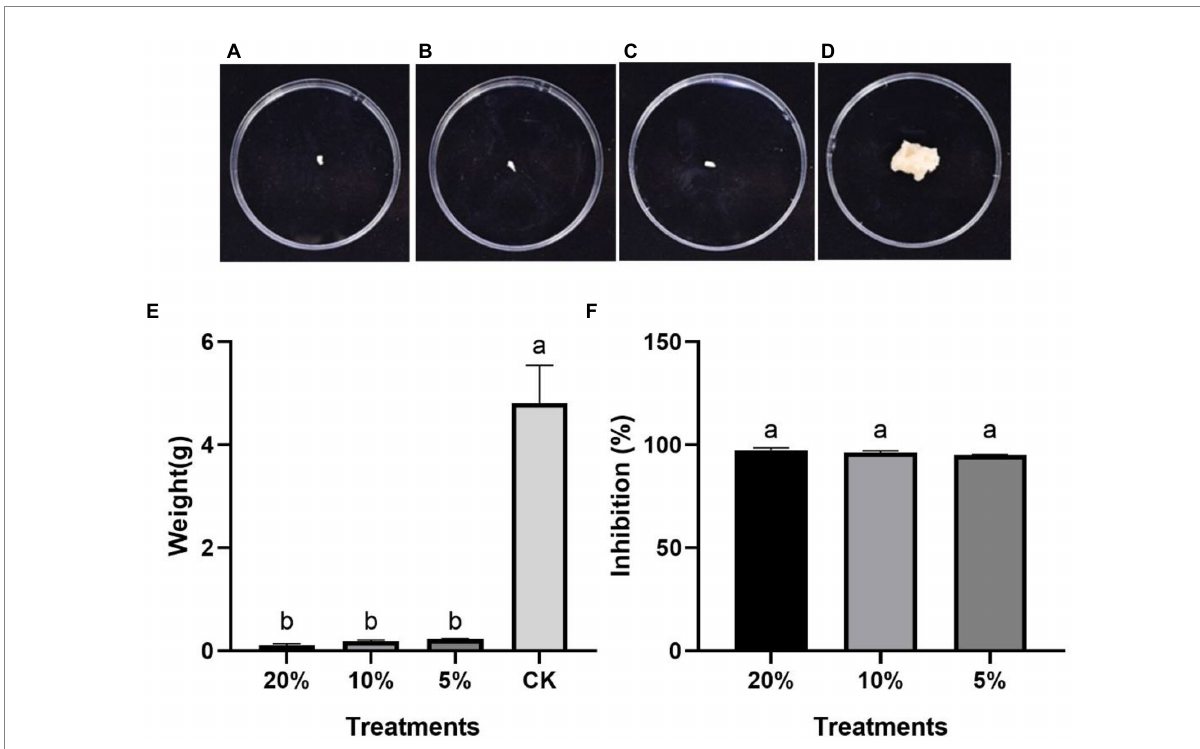
FIGURE 2 The suppression of P. protegens on the mycelia growth of B. dothidea in the PDB medium. The mycelia incubated with shaking in the PDB medium supplemented with 20% (A) , 10% (B) , and 5% (C) of P. protegens and the control mycelia (D) for 2 days. (E) The weight of mycelia from different treatments (E) . The inhibition of various concentrations of P. protegens to the fungus B. dothidea (F) . Lowercase letters indicate a significant difference between treatments ( p <